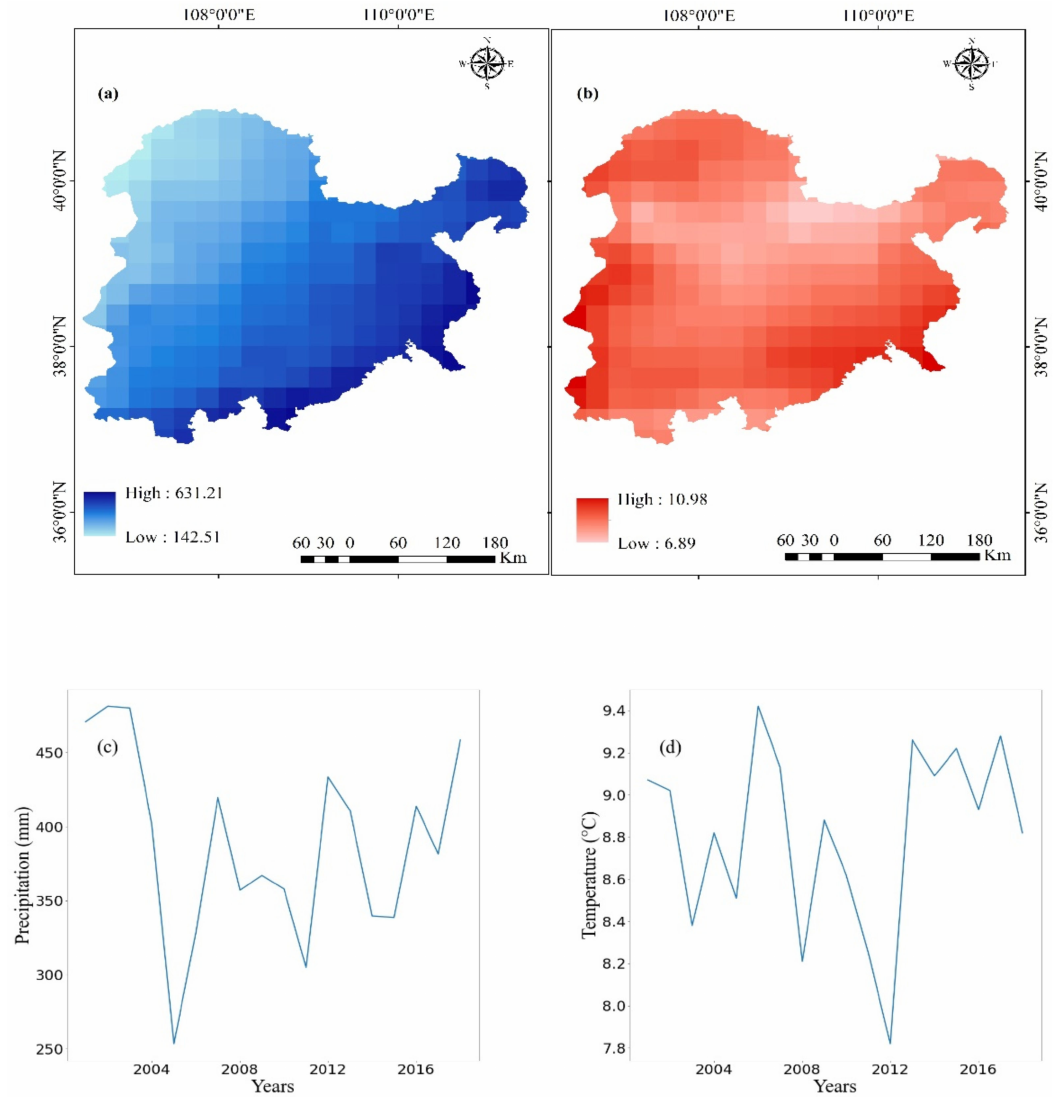
Figure 2. ( a ) Total Precipitation (2001–2018) ( b ) Annual Mean Temperature (2001–2018) ( c ) Total Precipitation Time Series (2001–2018) ( d ) Annual mean Temperature Time Series